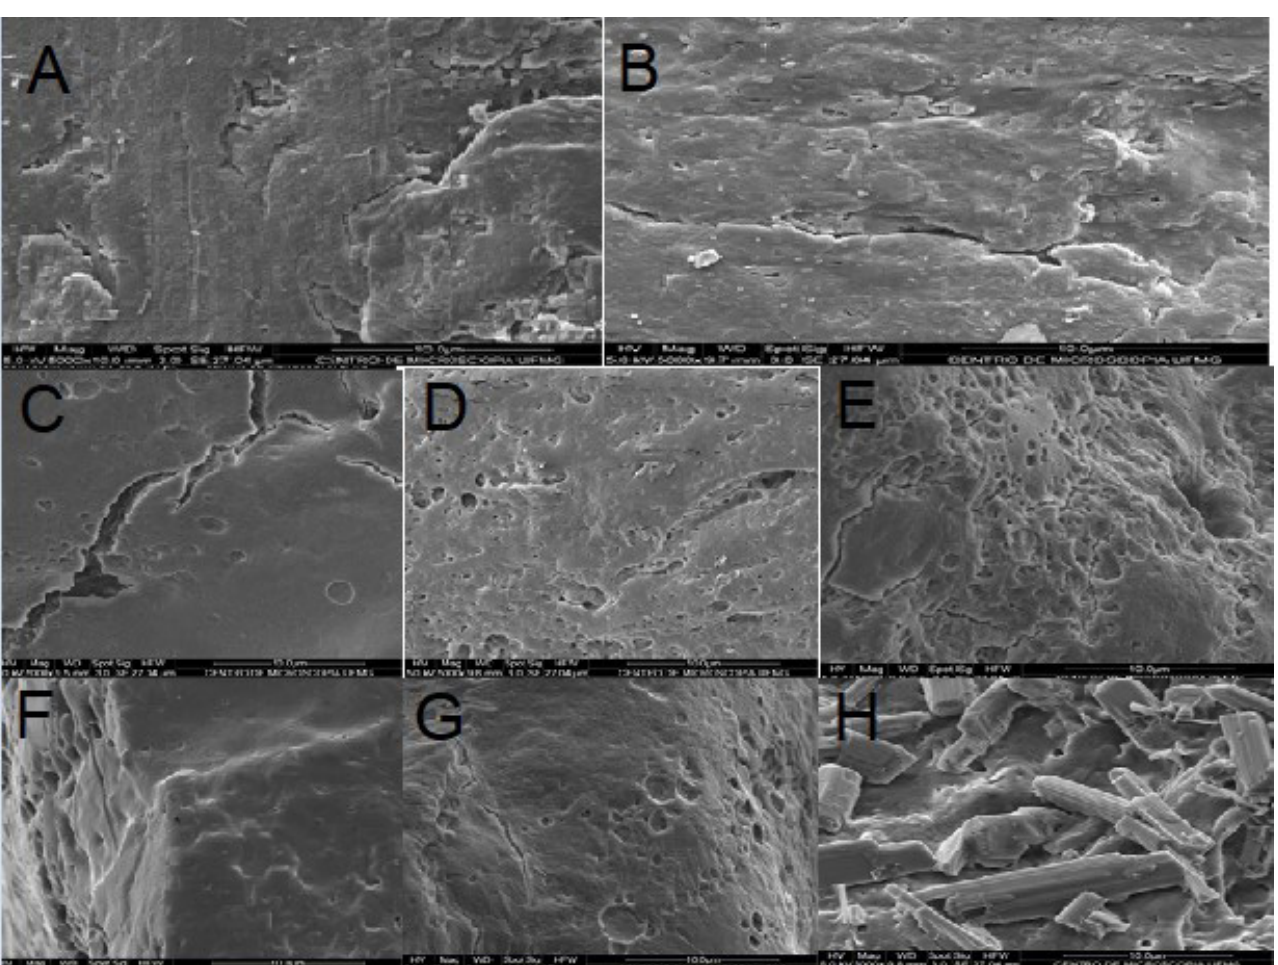
FIGURE 6 - Micrographs of the implants before the in vitro test for CBV-PLGA (A) and NBV-PLGA (A) at 5000x magnification. Micrographs during the 24h in vitro release test: CBV-PLGA (C), NBV-PLGA (F); 48 h: CBV-PLGA (D), NBV-PLGA (G); and 72h: CBV-PLGA (E), NBV-PLGA (H). Pore formation and polymer erosion can be